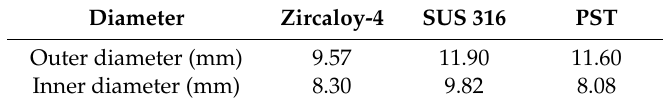
Table 2. Outer diameters and inner diameters of the metal tubes before and after